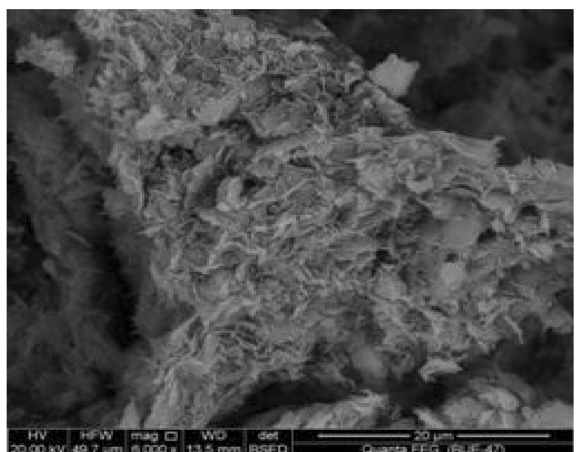
Fig. 7 SEM image (X 200)—detrital clays filling quartz grains and some alterations at few areas with Illite (Core # 9-B)